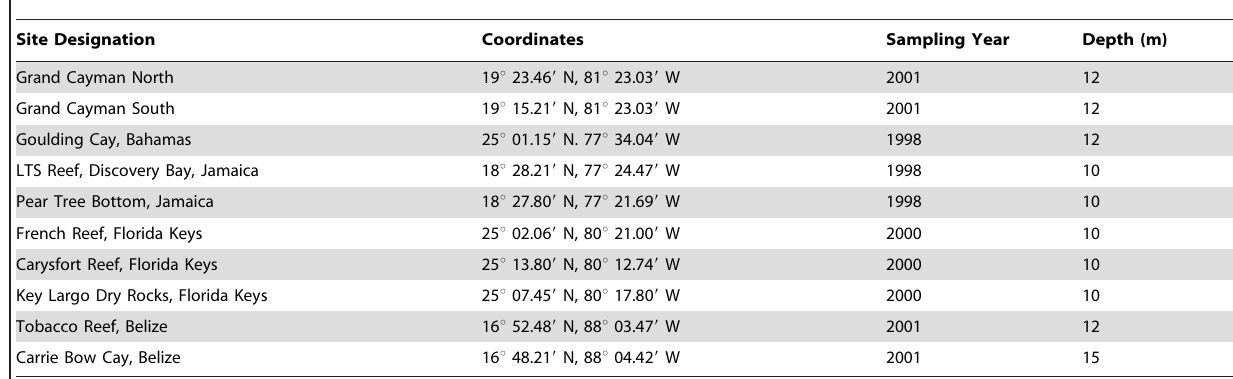
Table 1. Descriptive information for the ten sites used in the